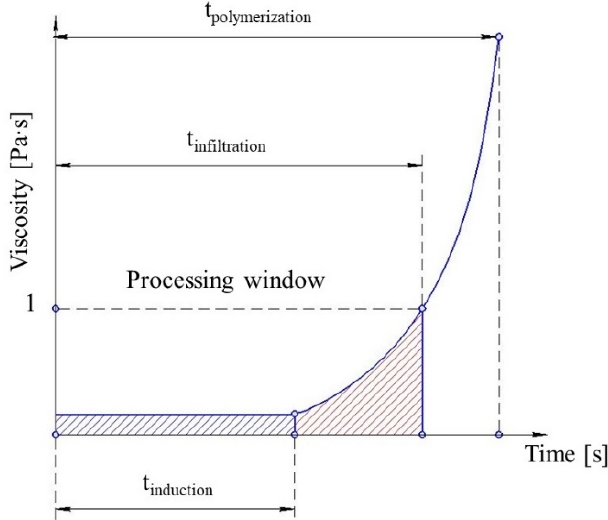
reactive Figure 3. Schematic representation of processing window limitations based on the viscosity of the reactive mixture.